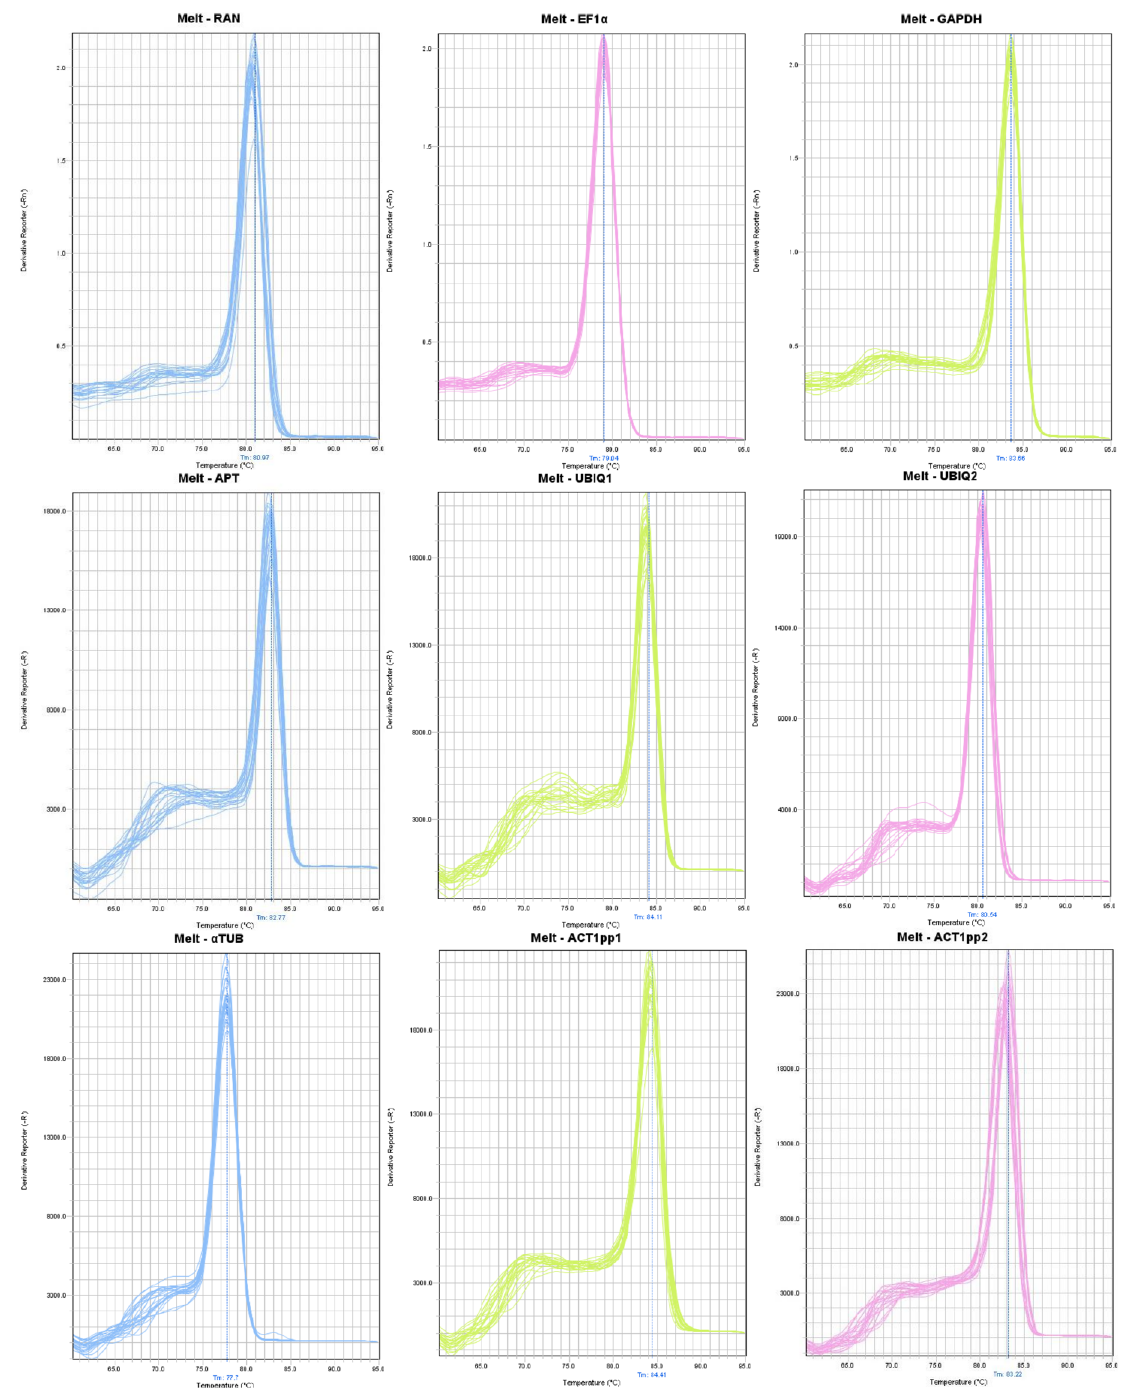
Figure 1. Dissociation curves of the candidate reference genes. Primers for genes ( ACT ) actin 1; ( APT ) adenine phosphoribosyltransferase; ( EF1 α ) elongation factor 1 alpha; ( GAPDH ) glyceraldehyde-3-phosphate dehydrogenase; ( α -TUB ) alpha-tubulin; ( RAN ) GTP-binding nuclear protein; ( UBQ1 ) ubiquitin 1 and ( UBQ2 ) ubiquitin 2, revealing single peaks, each obtained from three technical replicates of different cDNA samples. No amplification was observed in negative controls lacking template